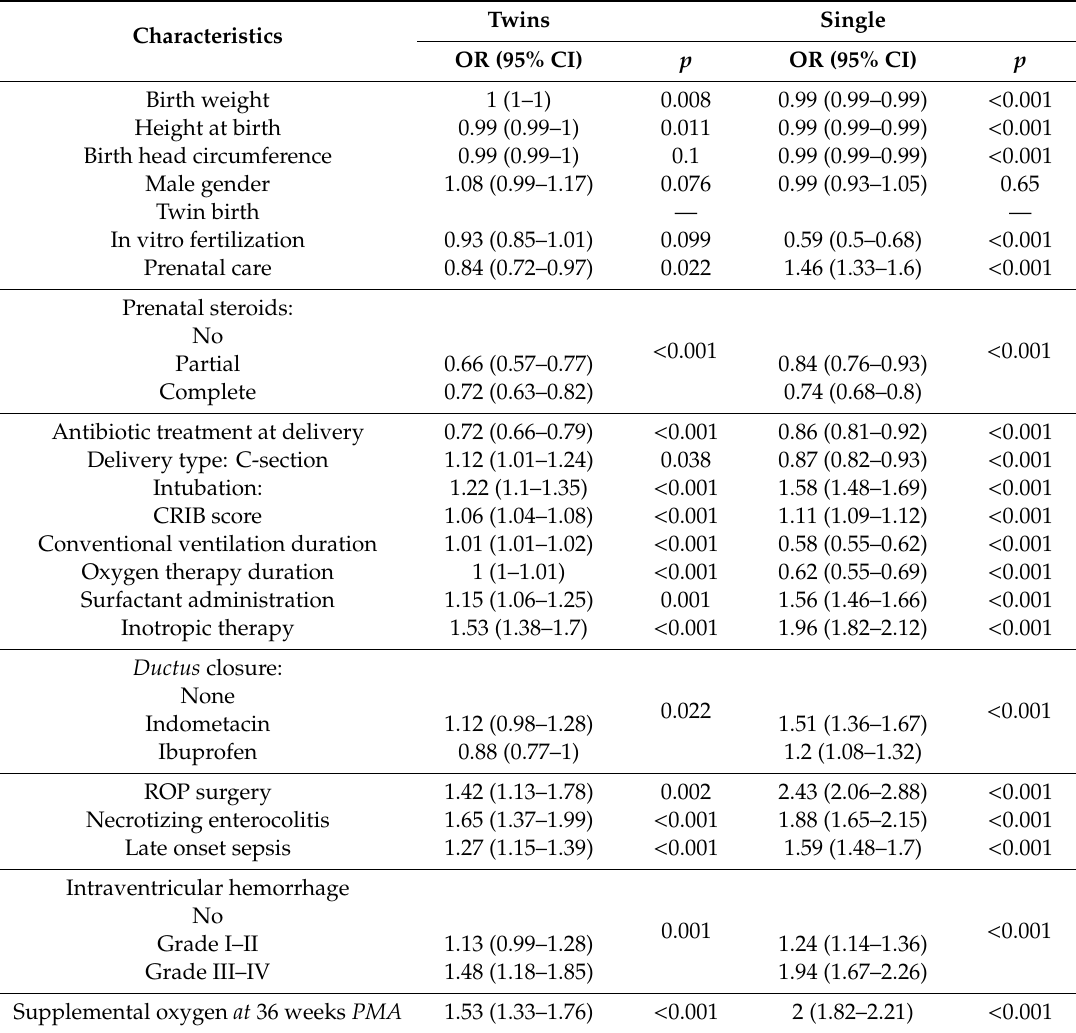
Table 3. Univariate analysis of risk factors for no breastfeeding at NICU